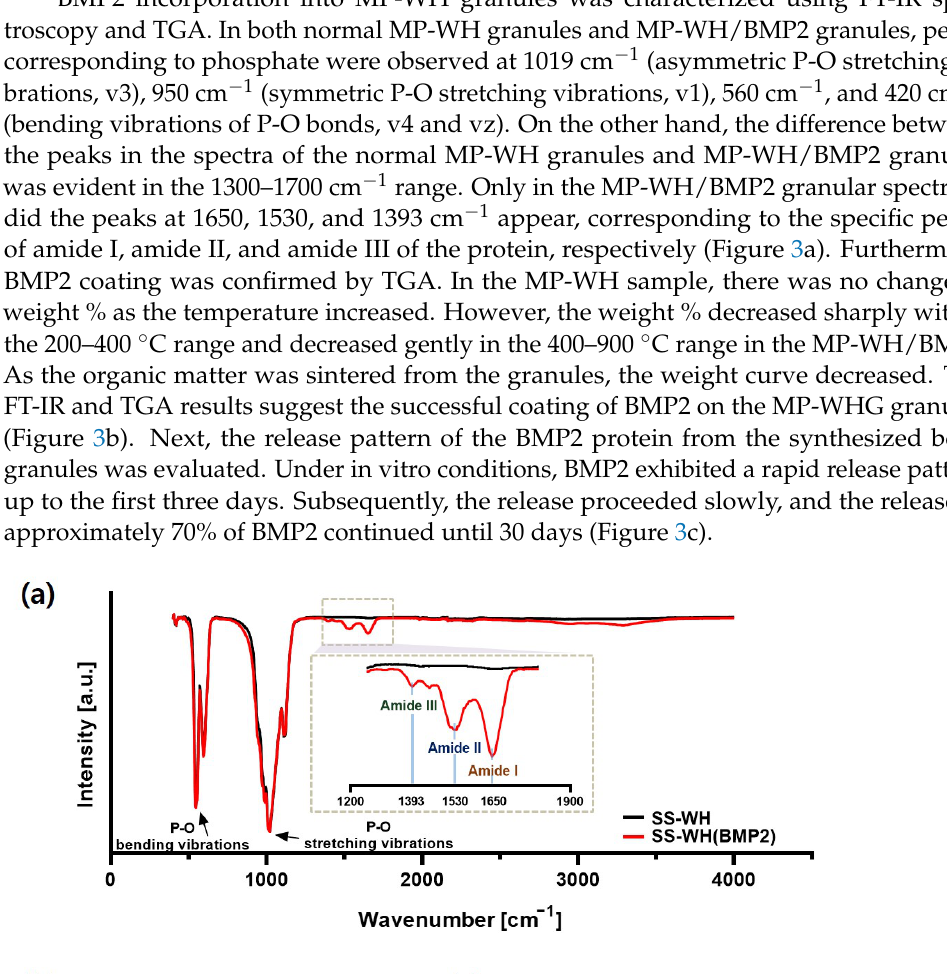
Figure 2. SEM images of BMP2-incorporating marine-plankton-derived WH granules. The images reveal that BMP2 irregularly covers the granules’ surface. Asterisks indicate the fraction of incorpo- rated BMP2.